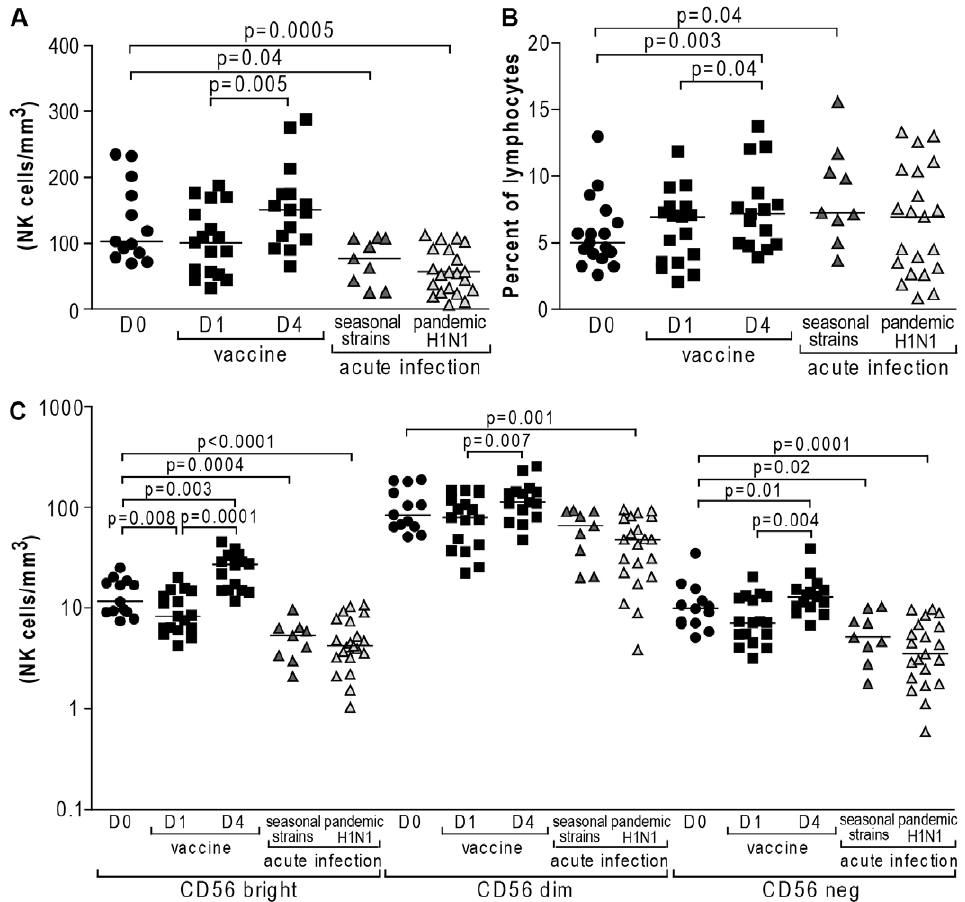
Figure 1. Changes in NK cell numbers and subset distribution in acute influenza infection and influenza vaccination. Dot plots represent (A), absolute numbers of NK cells (B), percentages of total NK cells and (C), absolute numbers of CD56 bright (CD3-CD56 + CD16 2 ), CD56 dim (CD3-CD56 + CD16 + ) and CD56 neg (CD3-CD56 2 CD16 + ) NK cells from 17 subjects prior to influenza vaccination, and at day 1 and 4 post-vaccination, 9 patients with acute seasonal influenza and 21 with acute 2009 pandemic H1N1 influenza virus infection. Complete blood counts at baseline were only available for 13 of the vaccinated subjects. Horizontal lines indicate the median percentages. Differences where p , 0.05 are indicated. ( healthy subjects prior vaccination; & , healthy subjects post-vaccination; dark grey m , acutely infected with 2009 seasonal influenza strains; light grey m , acutely infected with 2009 pandemic H1N1 influenza virus). D: day post-vaccination.